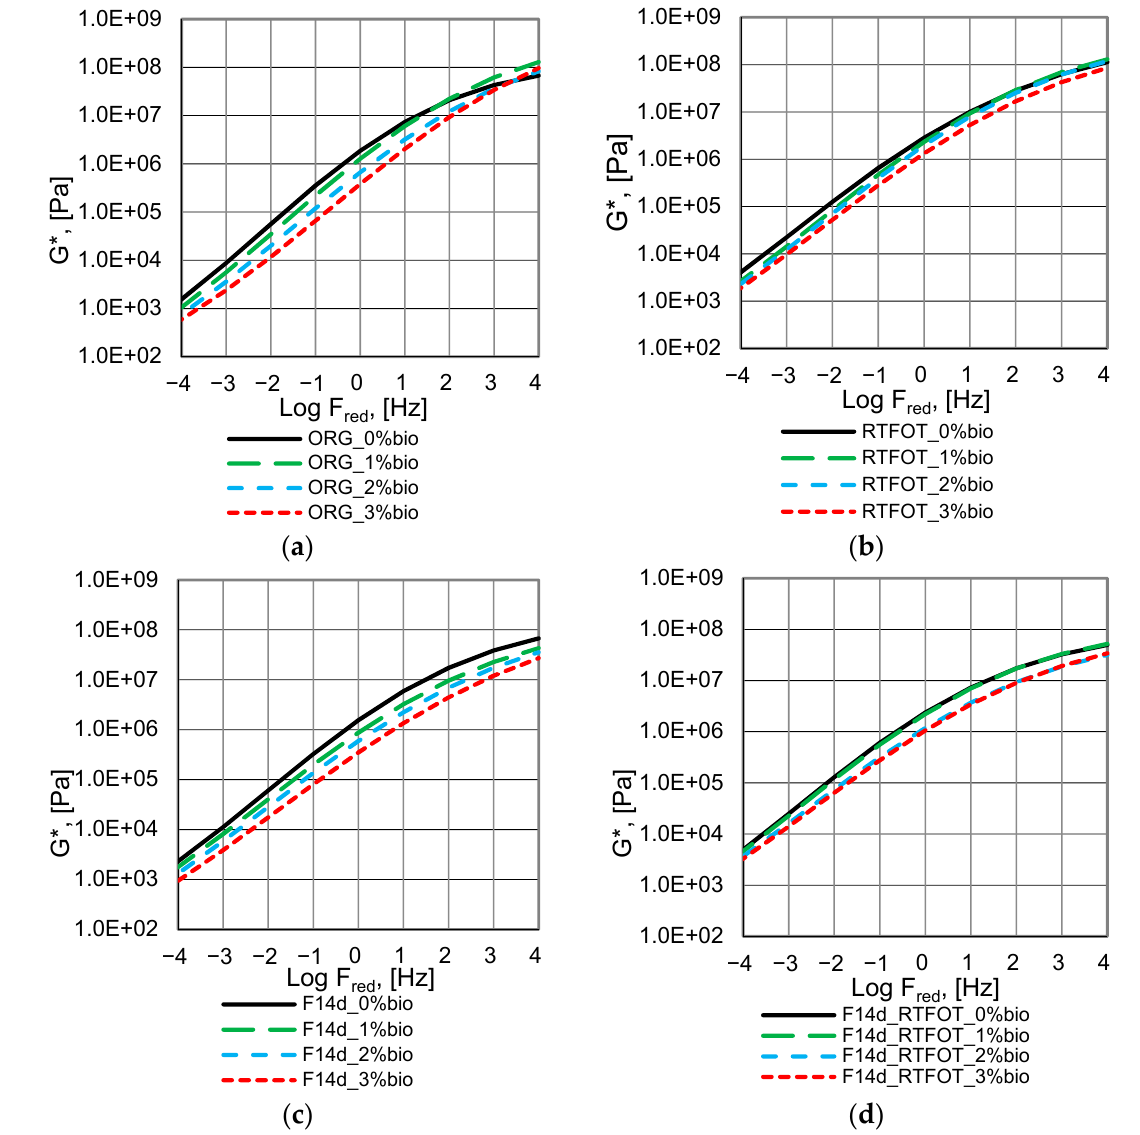
Figure 5. Master curves of c omplex modulus G* of the 45/80–55 polymer-modified bitumen: ( a ) non-foamed original bitumen (ORG), ( b ) non-foamed after RTFOT ageing bitumen (RTFOT), ( c ) foamed original bitumen (F14d), and ( d ) foamed after RTFOT ageing bitumen (F14d_RTFOT).